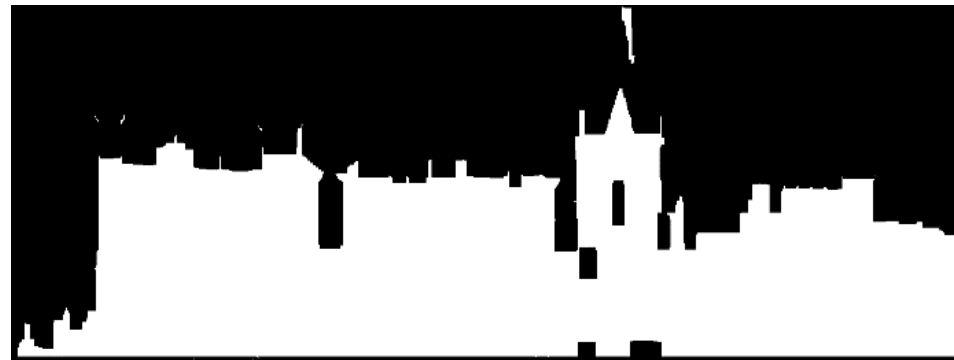
Figure 8. Projection image after dilation and erosion processing.